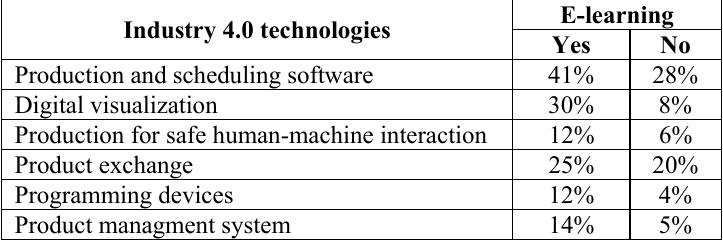
Table 2. Industry 4.0 technologies and e-learning